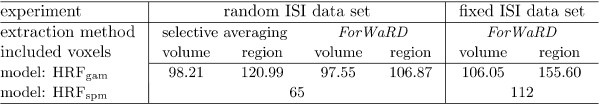
Maximum variance ratio values found in the tests.